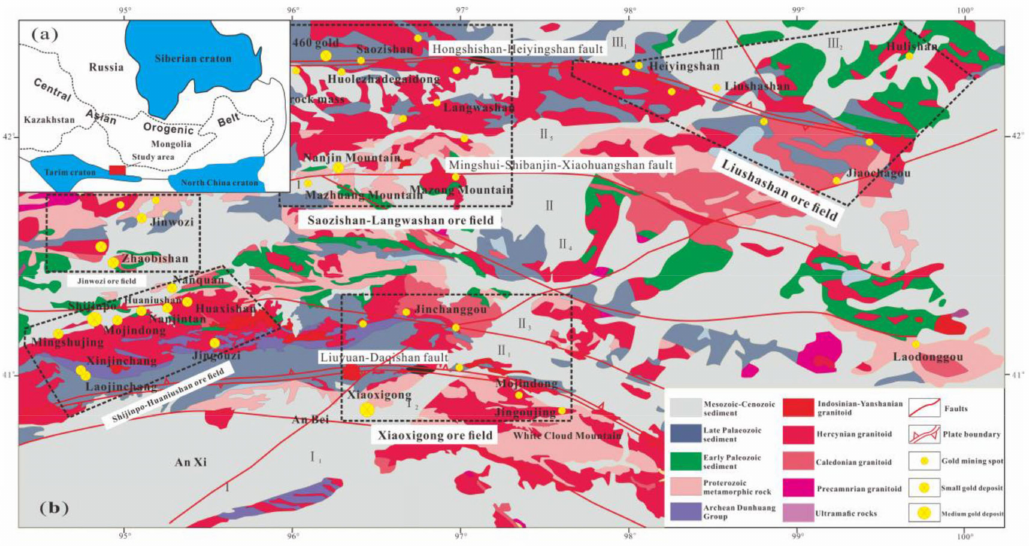
Figure 1. ( a ) Geotectonic geological background map of the study area; ( b ) Geological map of Beishan region showing the locations of significant Au